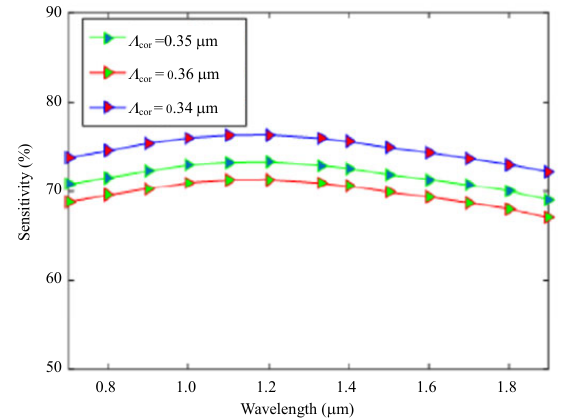
Fig. 5 Variation of sensitivity verses applied wavelength due to tuning the core pitch when other parameters are kept